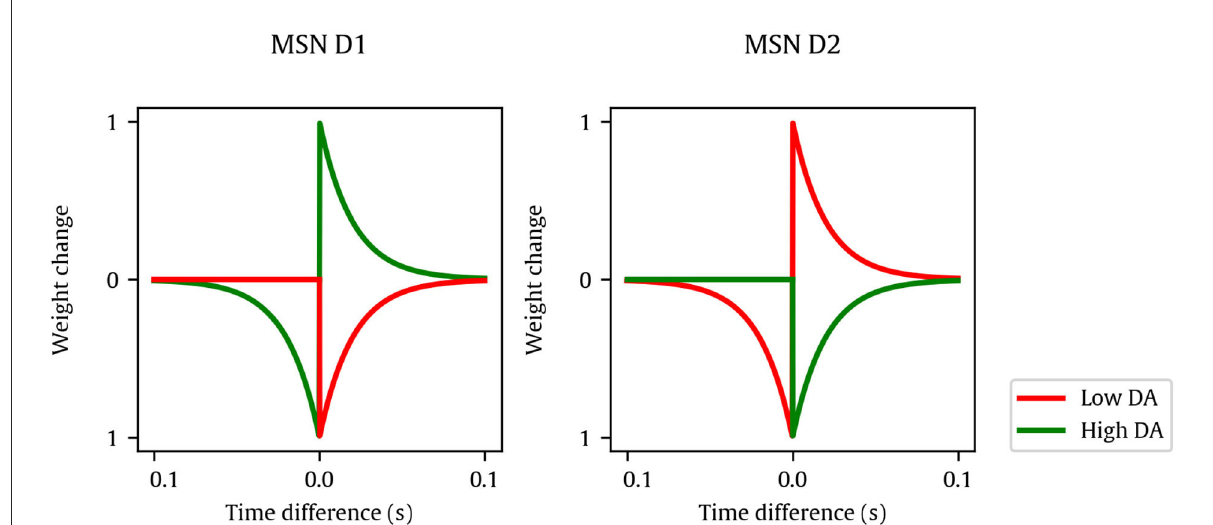
FIGURE2 Manually-tuned kernels used for spike-timing-dependent eligibility (STDE) synapses of MSN D1 (left) and D2 (right) , showing the weight change depending on the time difference between pre- and post-synaptic spikes and dopamine. Lines represent kernels at dopamine minimum and maximum values (red and green,